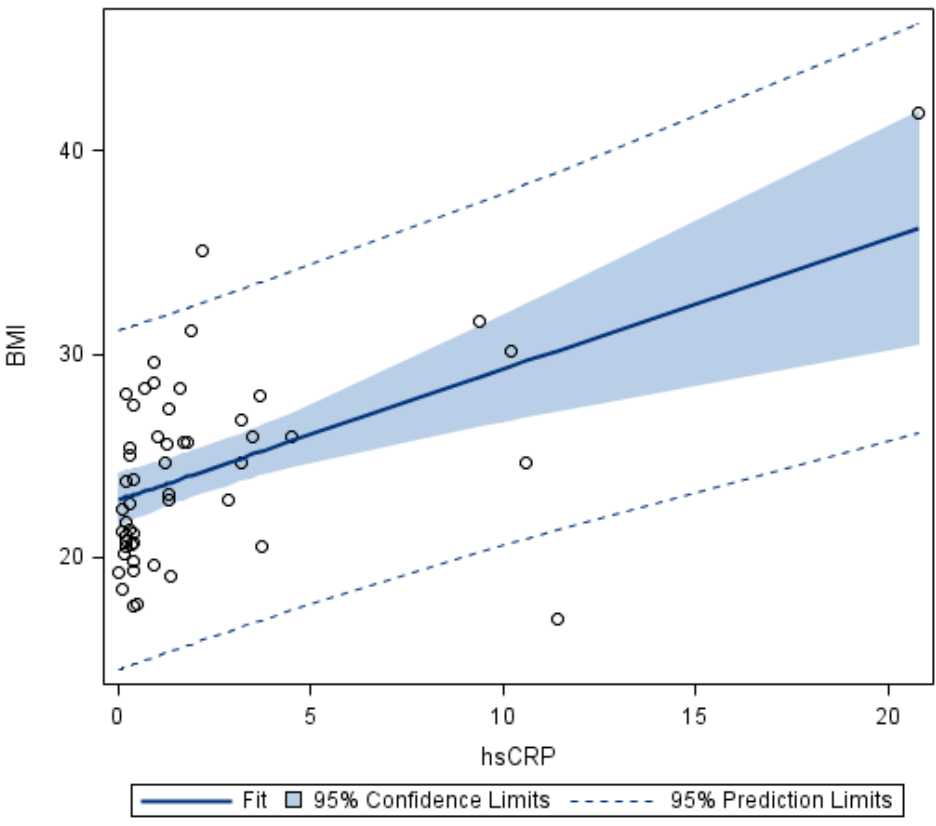
Figure 3. Linear regression of BMI and hsCRP in asthmatics. Moderately strong, statistically signif-